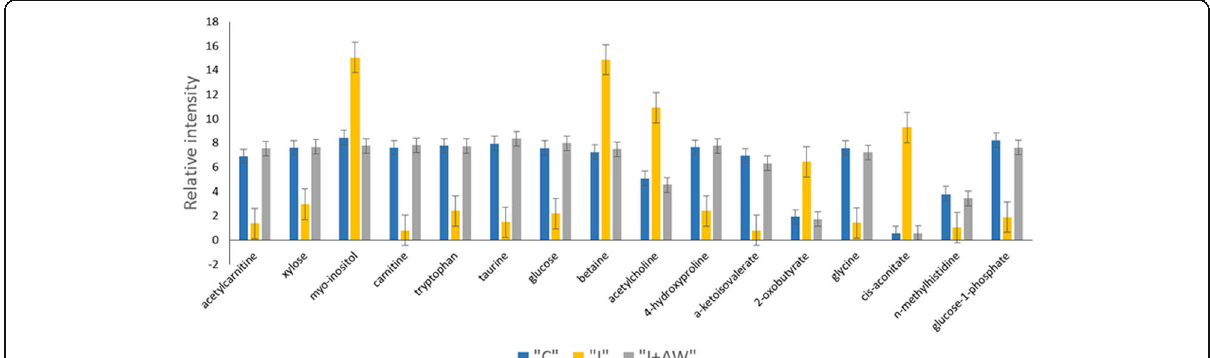
Fig. 10 Stomach tissue levels of 16 metabolites reversed nearly to control values after treatment with AW extract. The Y-axis represents relative peak intensities of the NMR spectra. ( “ C ” : control group, “ I ” : rats with indomethacin-induced gastric ulcer, “ I + AW ” : ulcerated rats treated with AW extract, Values are shown as mean ±